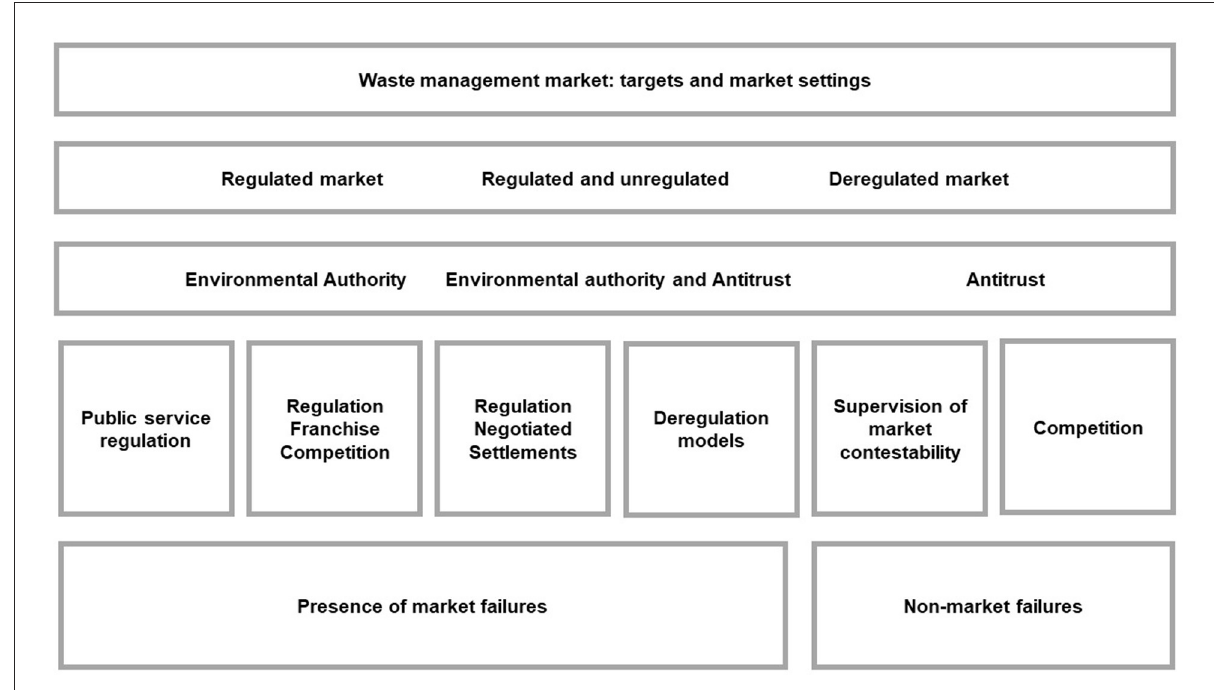
FIGURE1 Market structure, competition policy, and regulation. Source: own elaboration based on (Decker,